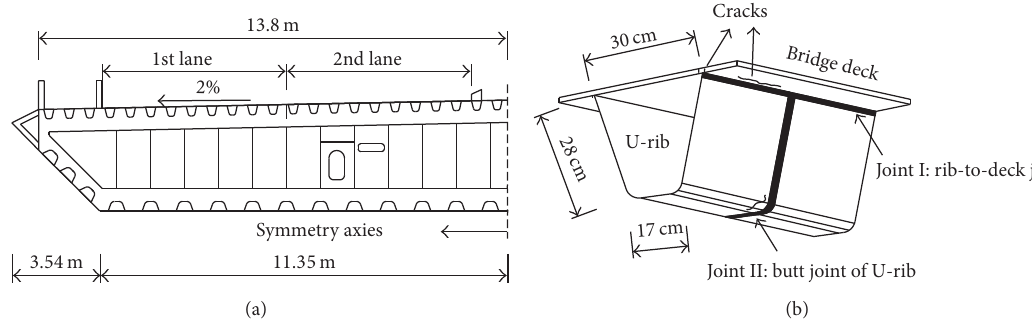
Figure 5: Dimensions of the steel box-girder: (a) half cross section and (b) U-rib.